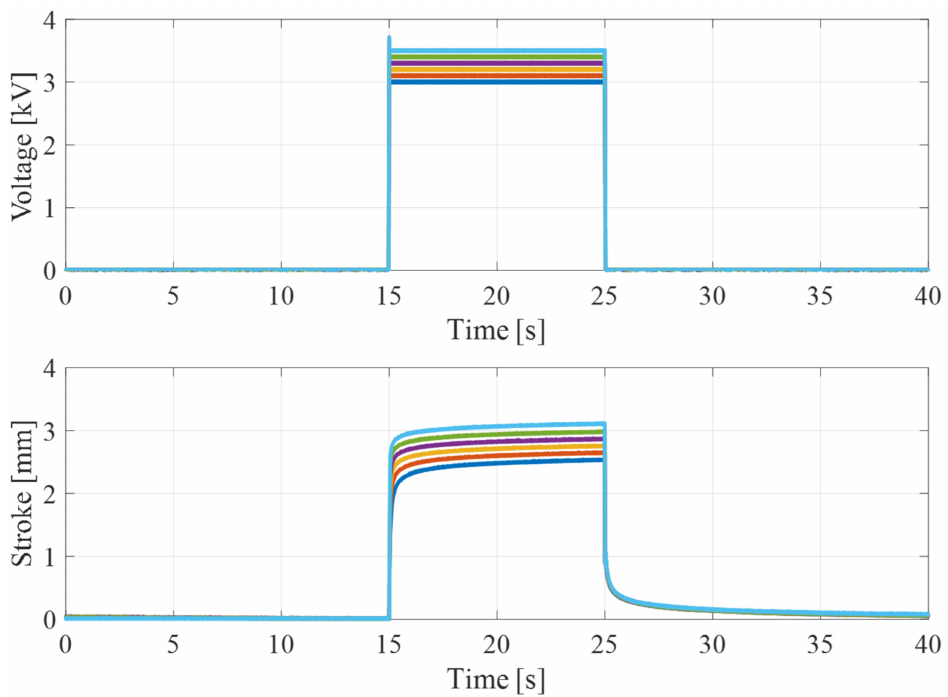
Figure 18. The upper part shows a step voltage signal applied as input, applied for a time of 10 s. The different colors represent signals of different amplitudes set as the input, which vary in the range 3–3.5 kV with increments of 0.1 kV. In the lower part, the corresponding stroke reached by the DEA is depicted.